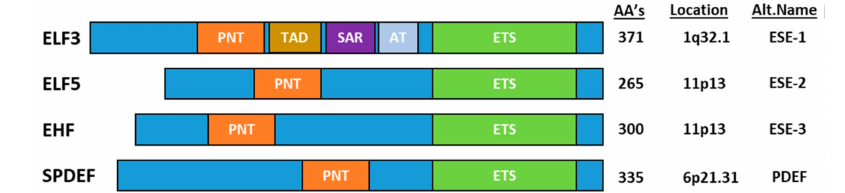
Figure 1. Schematic representation of the epithelial-epecific ETS transcription factors. Adapted from Feldman et al., 2003 [5] and Archer et al., 2017 [6].